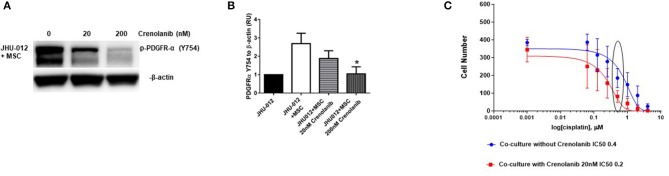
Inhibition of PDGFR-α with crenolanib decreases expression of activated PDGFR-α and improves responsiveness to cisplatin in OSCC. (A,B) JHU-012 were grown in 1:1 co-culture with MSCs in the presence and absence of the receptor tyrosine kinase inhibitor, crenolanib, for 6 days and PDGFR-α expression measured by Western immunoblotting. PDGFR-α expression was decreased following 20 nM treatment and 200 nM treatment with crenolanib. Expression levels were quantified by densitometry which revealed a significant decrease in PDGFR-α expression following treatment with 200 nM crenolanib (n = 3; *p < 0.04). Using a clonogenic assay, cisplatin dose response curves were generated from clones grown from JHU-012 (C) grown in 1:1 co-culture with MSCs with and without 20 nM crenolanib. There was a significant shift in the cisplatin dose response curve and the IC50 was reduced by half in JHU-012 (p < 0.0001) cancer cell clones treated with 20 nM crenolanib compared to untreated cancer cell clones (n ≤ 3).